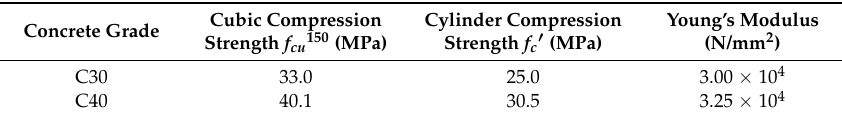
Table 3. Mechanical properties of